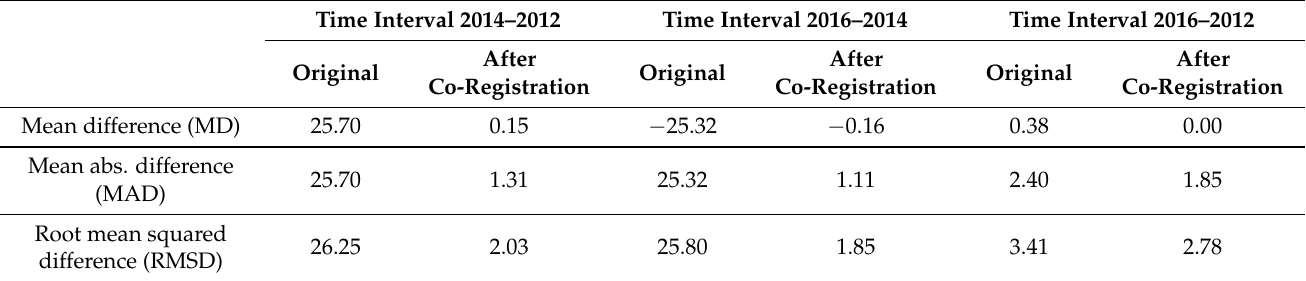
Figure 2. The selected stable sections in this area and corresponding results for the co-registration process. ( a ) The selected stable sections (in purple) in this area used for the co-registration process. ( b ) The histogram showing the shift in the difference in elevation values (m) for the Digital Elevation Model (DEM) from 2014 to the one of 2012 after the co-registration process. ( c ) The histogram for the DEM from 2016 to the one of 2014. ( d ) The histogram for the DEM from 2016 to the one of 2012. Table 2. The statistics of difference indicators resulting from the co-registration process (Unit: